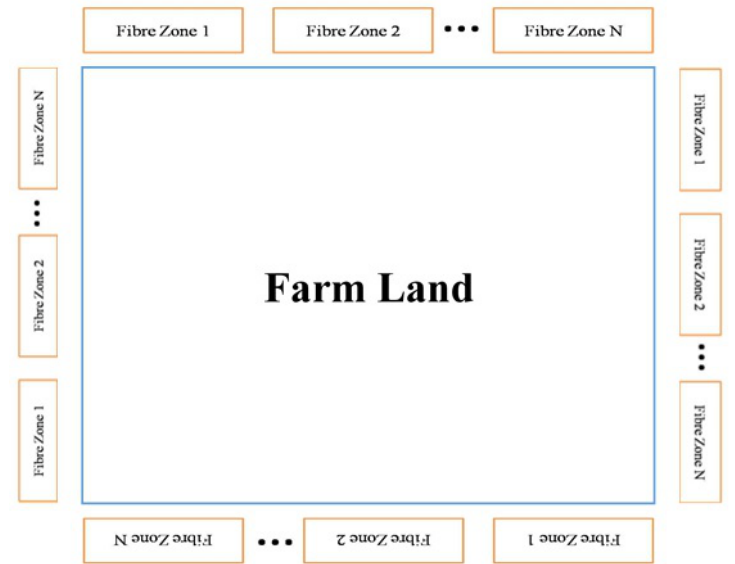
Figure 2. Arrangement of fiber zones in